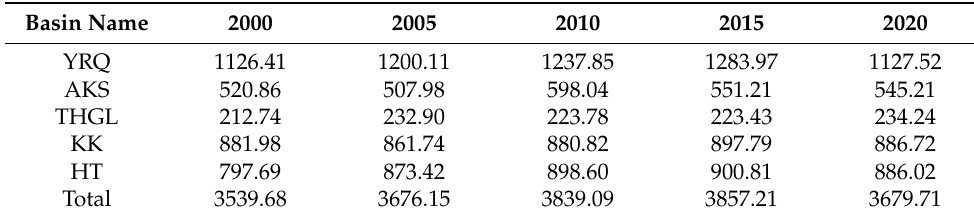
Table 3. ESV in the TRB (CNY 100 million).